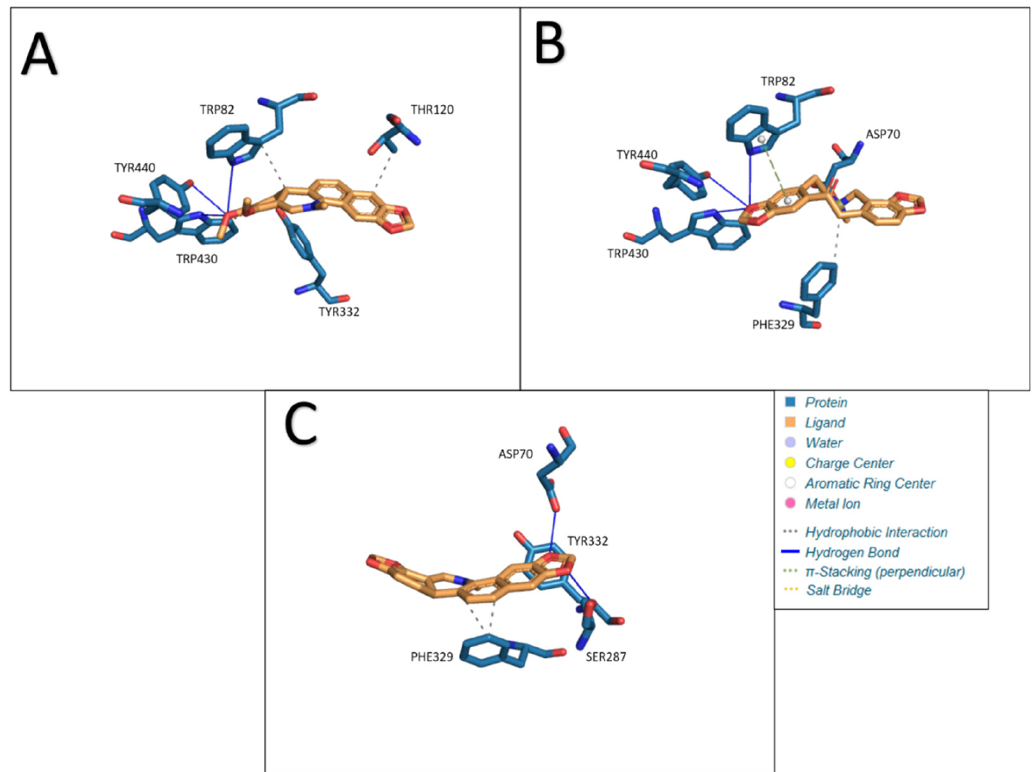
Figure 8. Interactions between BChE and ligands: ( A ) chelerythrine, ( B ) protopine, ( C ) sanguinarine.